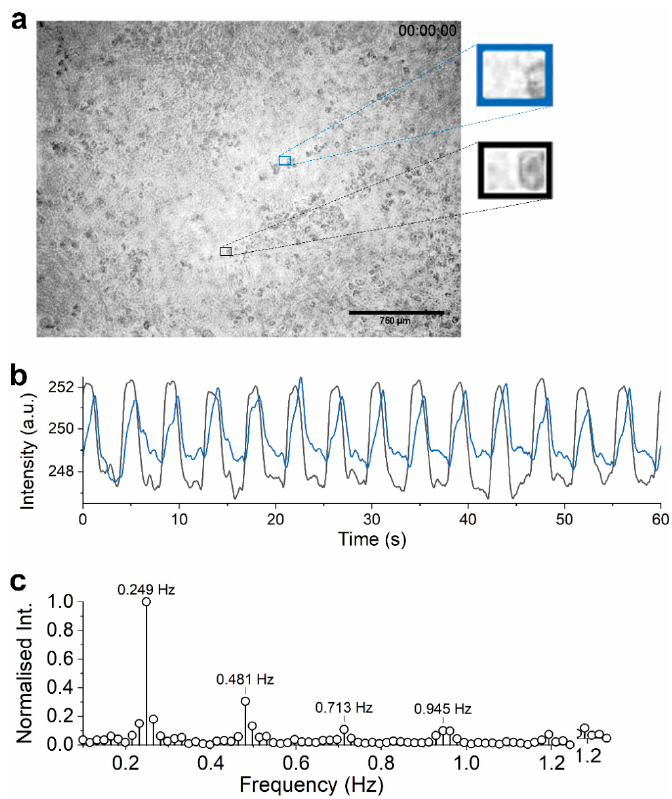
Figure 4. Visual data and their analyses recorded in the well-plate setup. ( a ) Still image of the recorded video of beating hPSC-CMs. Frames note example areas (35 by 25 pixels; corresponding to 85 by 60 µ m) that were analysed. ( b ) Mean intensity over time of the two areas noted in ( a ), filtered by moving average (N = 50 frames, corresponding to 0.5 s integration time) for clarity. The black frame on the image corresponds to the black line in this graph, blue frame to the blue line. The graphs have different waveforms as well as a slight phase difference. ( c ) Frequency components of the recorded average intensity of the area in black frame in ( a ) (corresponds to the black graph in ( b